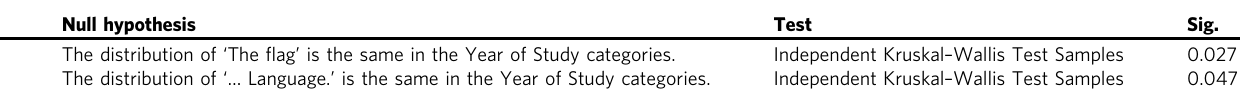
Table 11 Non-parametric Kruskal – Wallis test of differences in rank scores given to identity symbols regarding the year of master study (1st or 2nd year of the Master ’ s Degree).